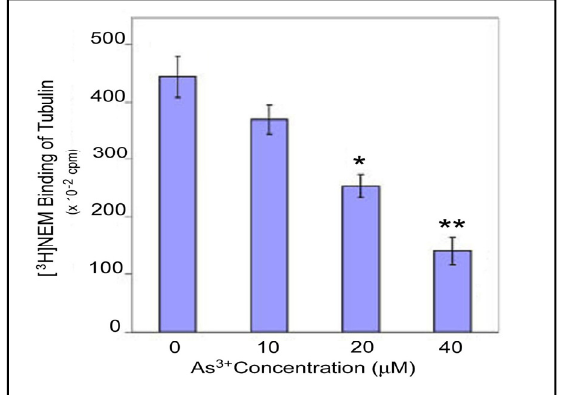
Figure 7. As 3+ binding to tubulins through -SH groups as revealed by [ 3 H]NEM binding assay. “Pure” tubulin free of MAP (1.5 mg/mL) prepared from bovine brain was pretreated with As 3+ at indicated concentrations for 2 h at 0  C, mixed with [ 3 H]NEM (2 µCi/mL), and incubated for an additional 2 h at 37  C. Proteins were precipitated with 5% TCA and filtered. Radioactivities coupled with collected proteins on the membrane were measured by β -counting. The significance of data presented was assessed by ANOVA analysis. * p < 0.05, ** p < 0.01 (n =